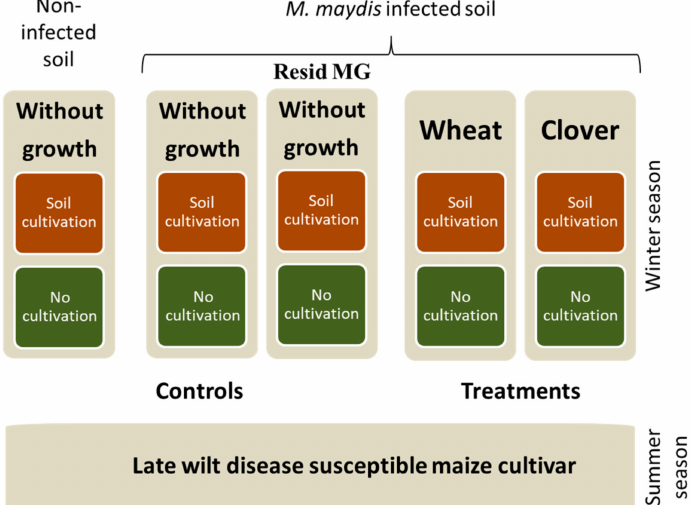
Figure 1. The greenhouse experiment program. The experiment was performed in greenhouse pots over an entire dual-growing season (winter cultivation followed by spring-summer cultivation). The late wilt disease (LWD) hyper-susceptible maize genotype Megaton cv. was grown on Magnaporthiop- sis maydis -infected soil and treated as follows: clover/maize crop rotation and wheat/maize crop rotation. The controls included the commercial Resid MG product (arbuscular mycorrhiza), which was tested as a soil addition instead of winter cropping. This product is based on Glomus iranicum var. tenuihypharum (Mico, Symborg S.L., Murcia, Spain, supplied by BioBee Biological Systems, Sde Eliyahu, Israel) and was added to the bare soil one week post maize sowing. Infected and uninfected soils that had not been cropped before the maize growth were also used as reference